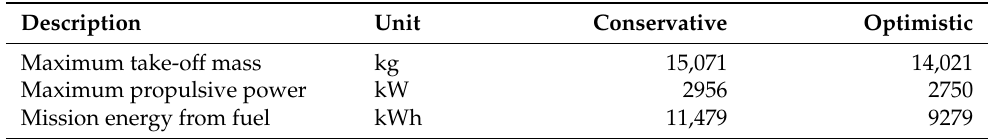
Table 6. Results from the initial sizing for conventional Architecture 0 as a reference for the following analyses. Fuel is given in kWh to allow comparisons with electrical energy and